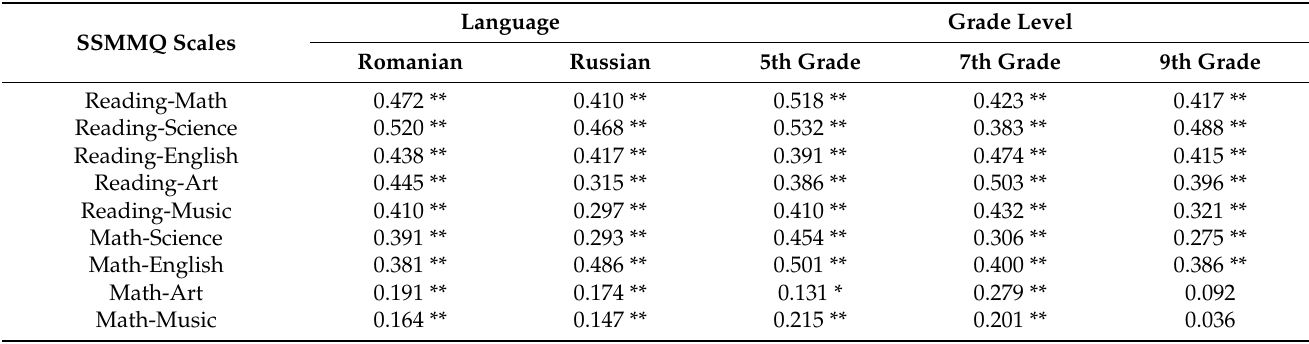
Table 6. Correlations of SSMMQ factors by language and